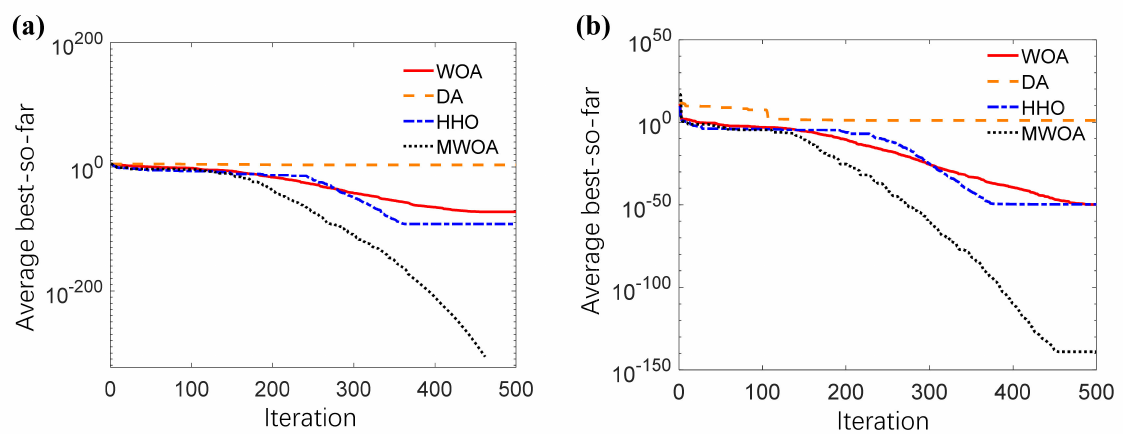
Figure 6. Convergence curves of four intelligent optimization algorithms. ( a ) Convergence curves for f 1 . ( b ) Convergence curves for f 2 . Average best-so-far means the average of the solution obtained so far in each iteration over 30 runs.